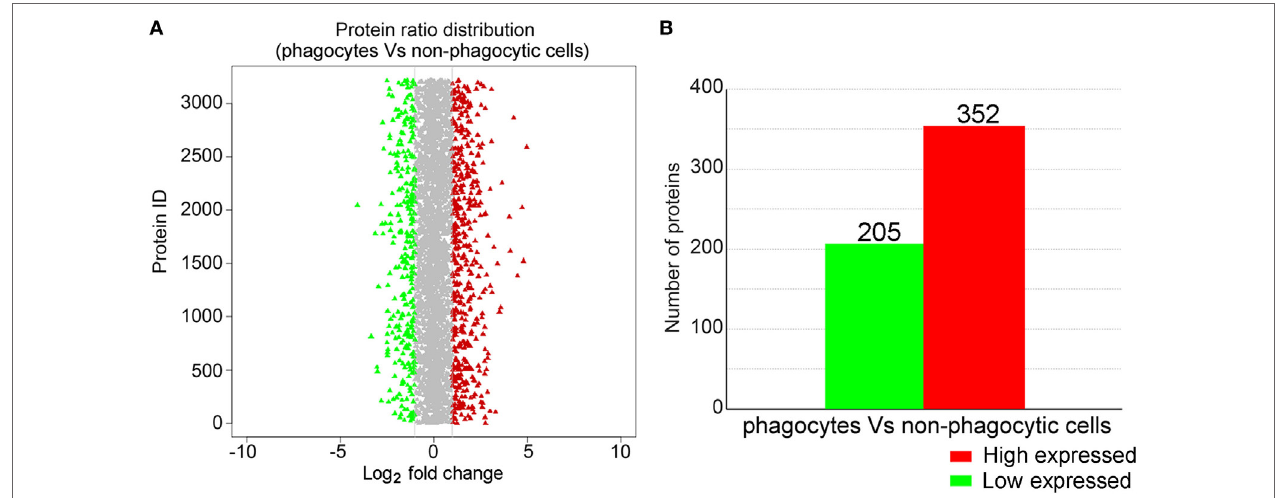
FigUre 3 | iTRAQ analysis of proteins differentially expressed in phagocytes. (a) This chart illustrates the overall protein expression level identified in phagocytes. The average log 2 -fold change for each protein is plotted, while those identified as either significantly high or low expressed are highlighted in red and green, respectively. (B) Statistical analysis of high and low expressed phagocyte differentially expressed proteins.